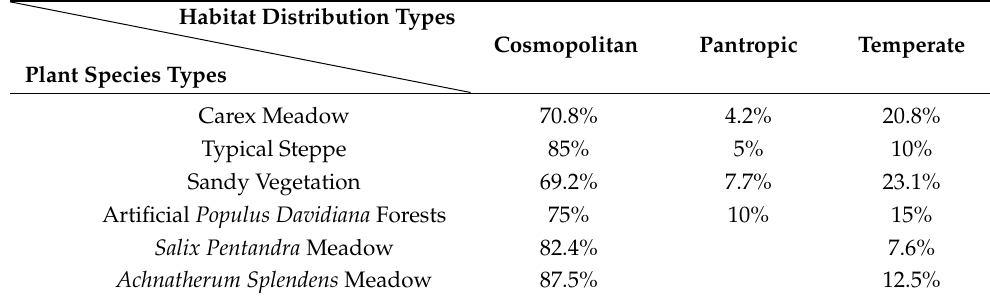
Table 1. The proportion of plant species in different distribution areas accounting for all kinds of habitat distributions in Baiyinkulun area. TypesHabitat Distribution Types Cosmopolitan Plant Species